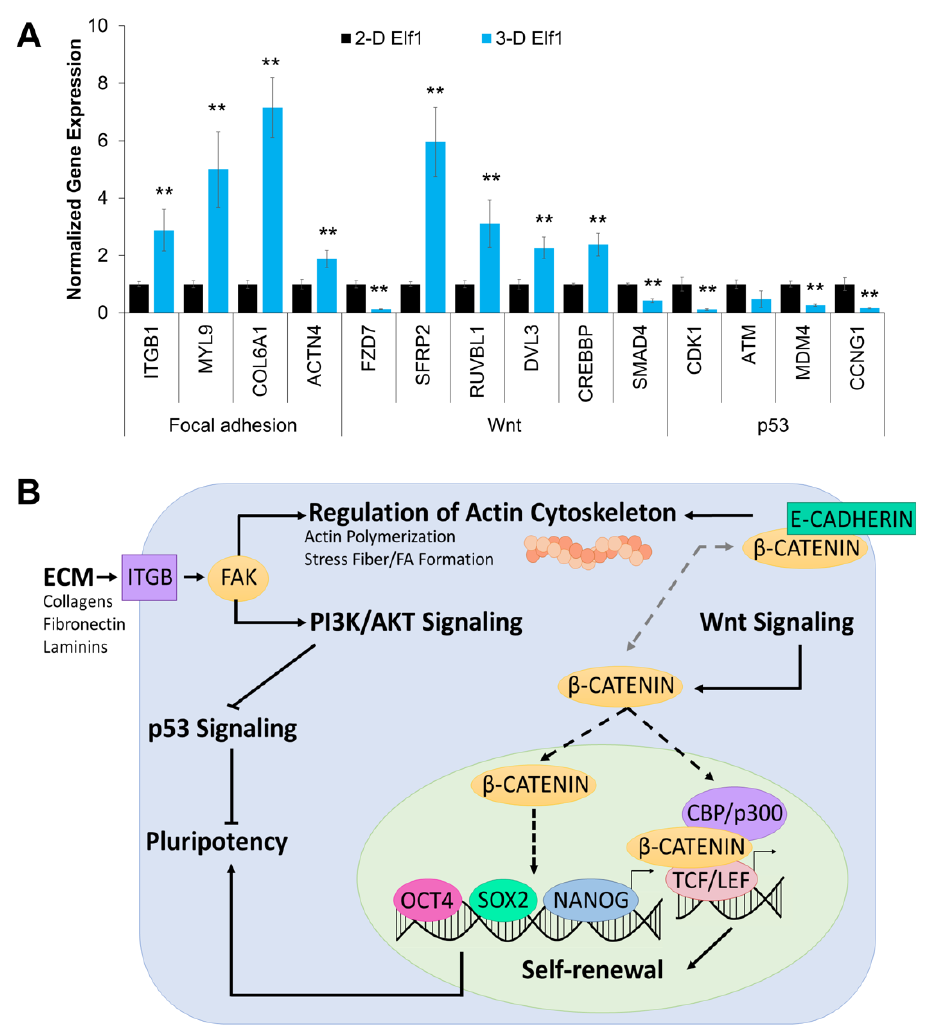
Figure 7. Analysis of genes involved in the maintenance of pluripotency in 3-D grown naïve ESCs. ( A ) 3-D culture conditions affected the expression of genes associated with focal adhesion, Wnt, and p53 signaling pathways as determined by qRT–PCR. Results were expressed as the fold expression ± SEM normalized to reference genes HMBS and GAPDH (** p < 0.01). ( B ) The proposed pathway involved in the maintenance of pluripotency of Elf1 cells grown under 3-D culture conditions.